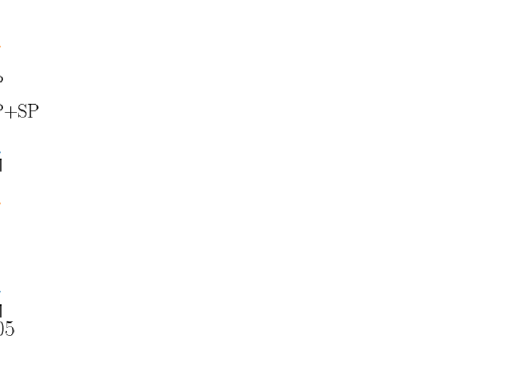
Figure 11. Desynchronization of a network of synchronized identical oscillators using RVS CR stimulation in two plasticity schemes, STDP and STDP + SP. The mean synaptic weight, (cid:31) W (cid:30) , (top) and the order parameter, R , (bottom) show the long-term desynchronization of a network with STDP while the network with STDP + SP goes back to synchrony. The shaded region highlights the time interval of stimulation. Parameters are a = 0.3 , γ = 3 ; stimulation parameters are duration = 70 min, intensity I s = 100 , and F s = 10